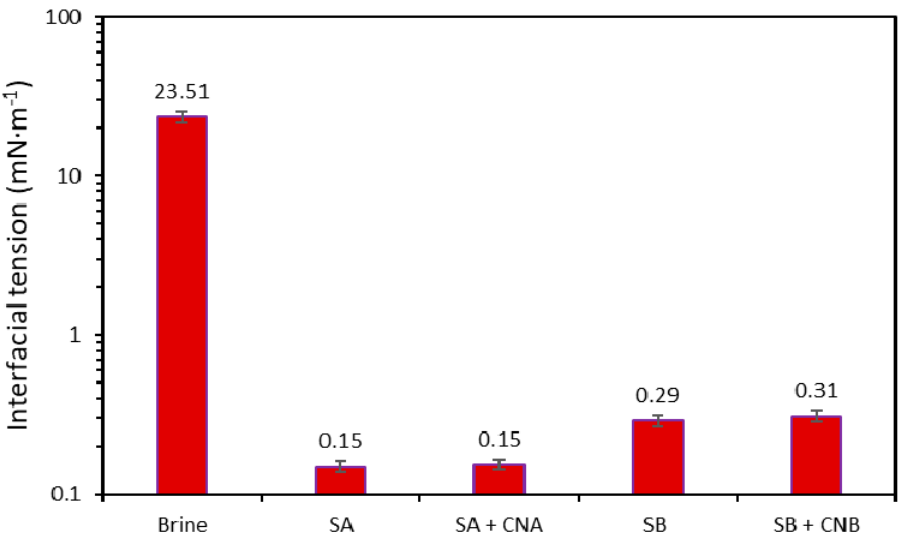
Figure 8. Interfacial tension measurements at a constant brine TDS of 0.75%. The tests were conducted at 50 °C at a fixed concentration of 1000 and 100 mg·L − 1 for each surfactant (SA and SB) and nanoparticle (CNA and CNB), respectively. The standard deviation is shown as error bars.